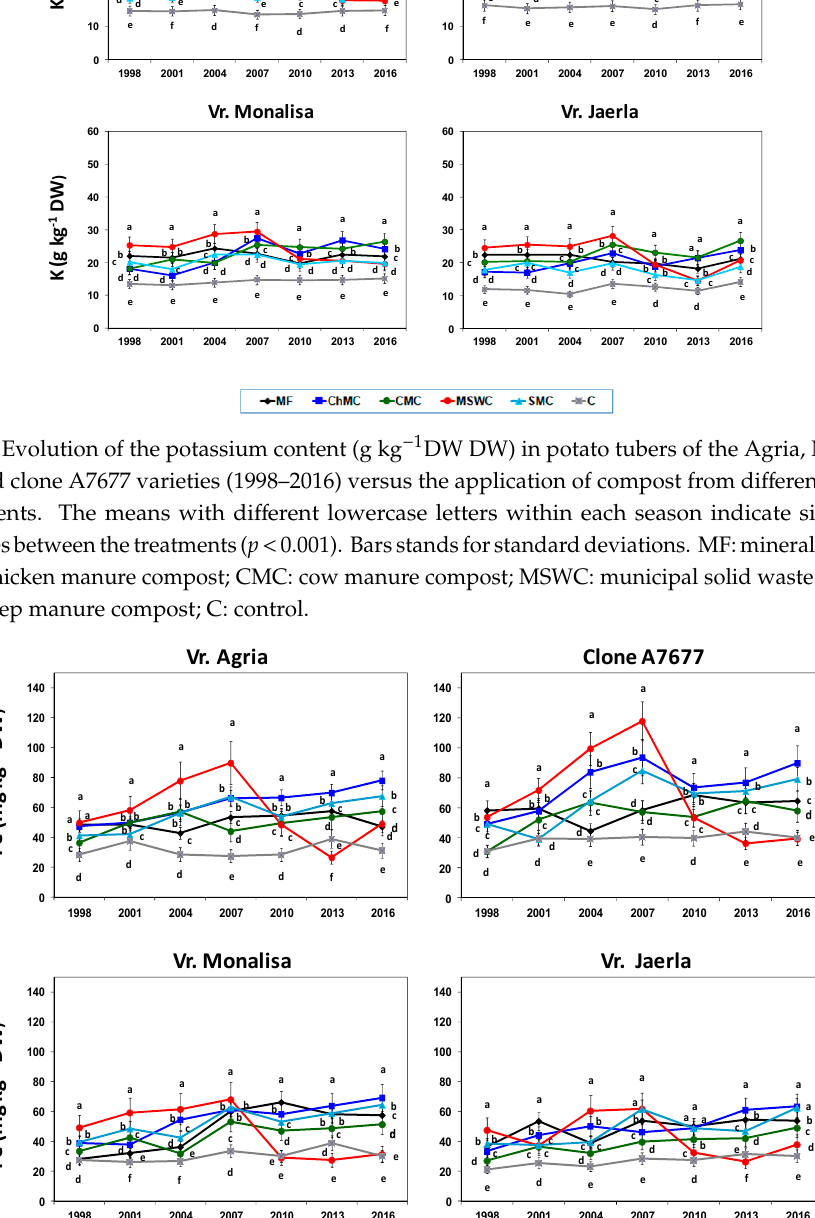
Figure 7. Evolution of iron content (mg kg − 1 DW) in potato tubers of the Agria, Monalisa, Jaerla and clone A7677 varieties (1998–2016) versus the application of compost from di ff erent organic amendments. The means with di ff erent lowercase letters within each season indicate significant di ff erences between the treatments ( p < 0.001). Bars stands for standard deviations. MF: mineral fertilizer; ChMC: chicken manure compost; CMC: cow manure compost; MSWC: municipal solid waste compost; SMC: sheep manure compost; C: